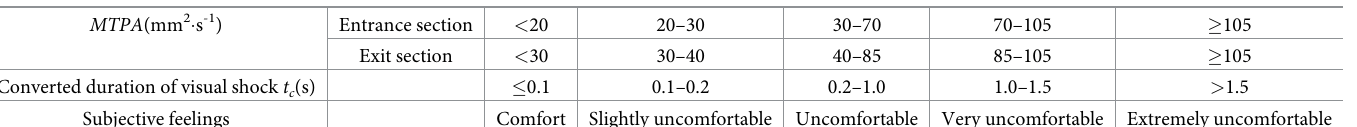
Table 1. Relationship between MTPA and visual